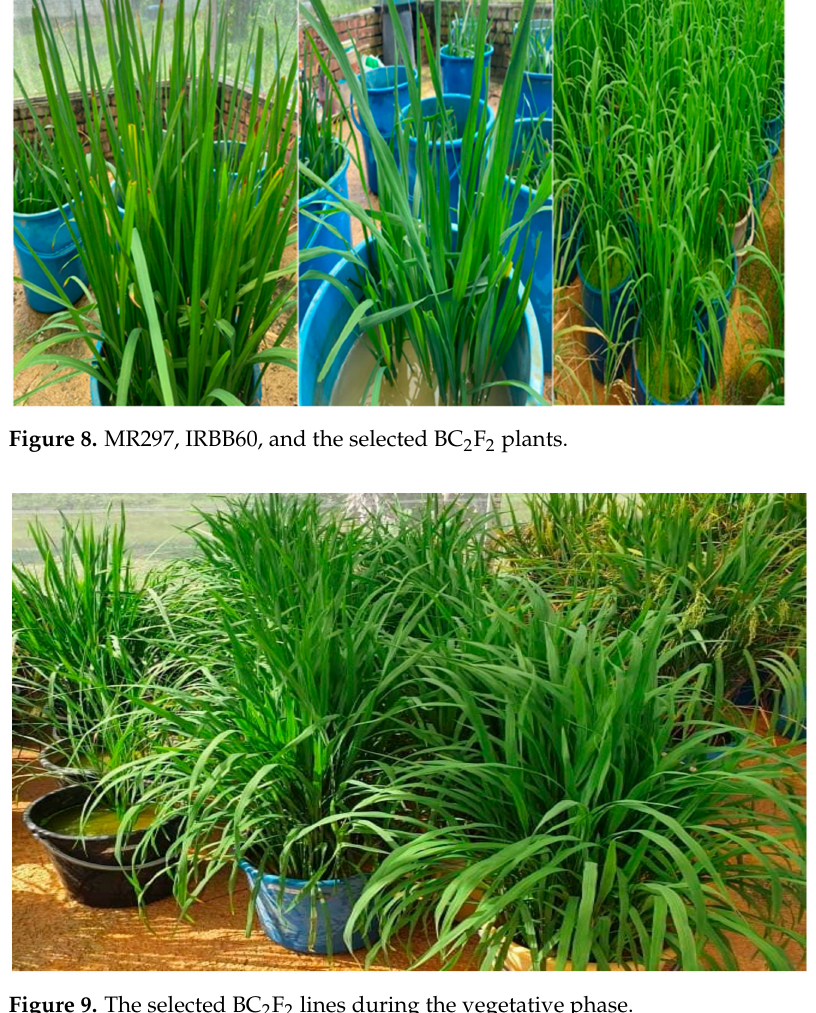
Figure 9. The selected BC 2 F 2 lines during the vegetative